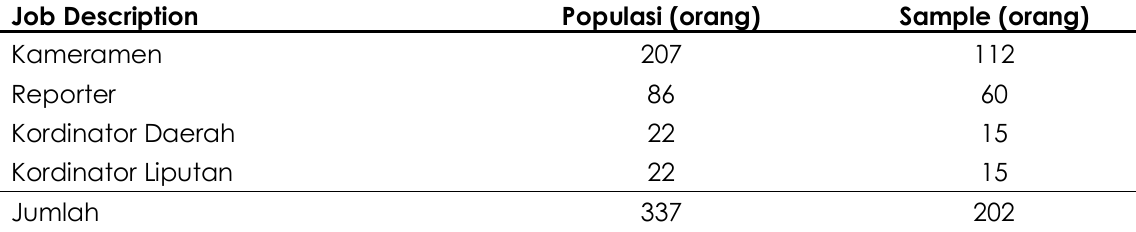
Tabel 3. Populasi dan sample (contoh) Job Description